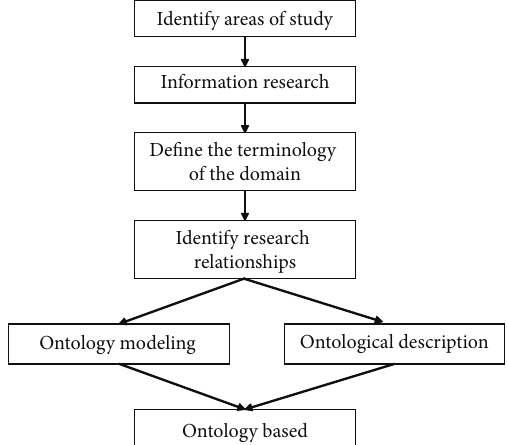
Figure 1: Ontology model building process.